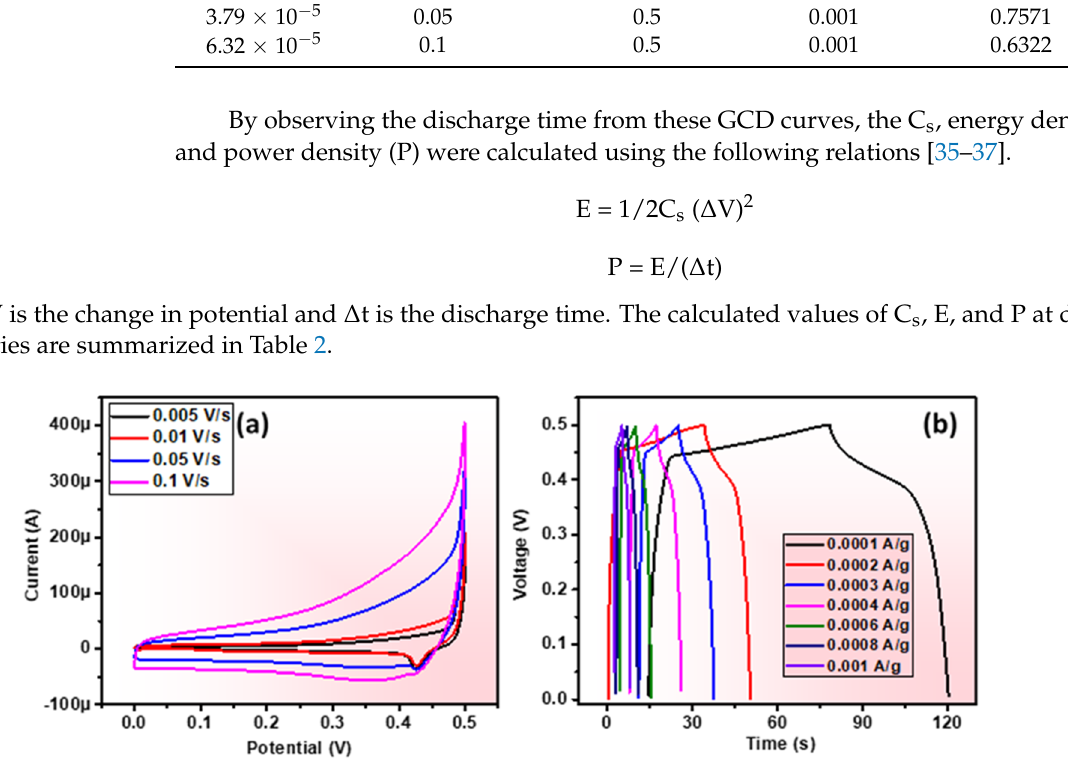
Figure 9. ( a ) CV curves and ( b ) GCD curves of CeO 2 /NiO nanocomposite. Table 2. Calculation of specific capacitance, energy density, and power density of CeO 2 /NiO nanocomposites.